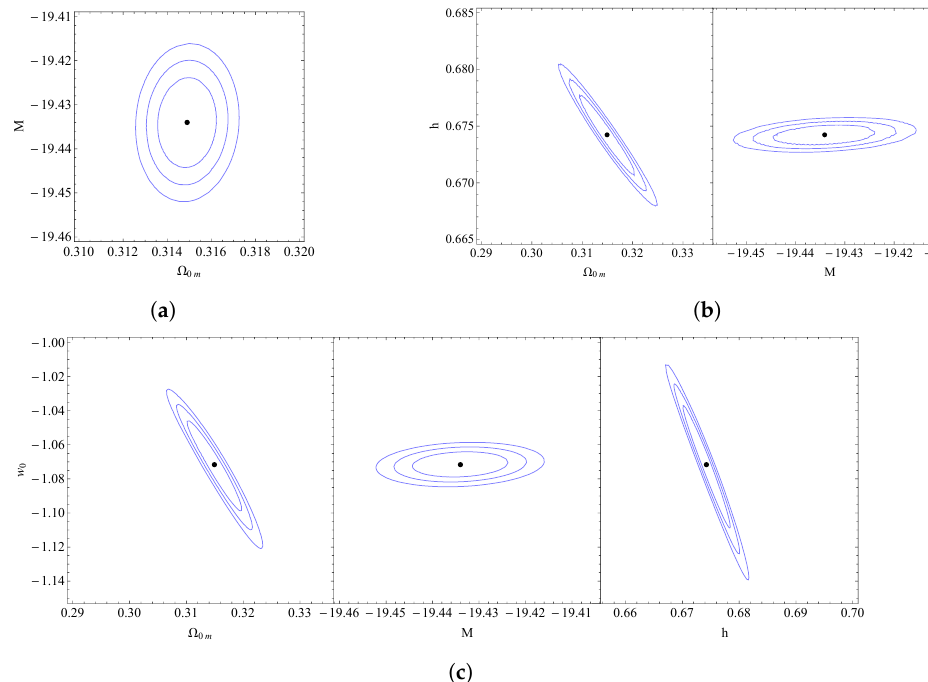
Figure 18. Confidence contours for the CPL model: ( a ) The 1 σ − 3 σ confidence contour in the parametric space ( M − Ω 0 m ) . ( b ) The 1 σ − 3 σ confidence contours in the parametric spaces ( h − Ω 0 m ) and ( h − M ) . ( c ) The 1 σ − 3 σ confidence contours in the parametric spaces ( w 0 − Ω 0 m ) , ( w 0 − M ) and ( w 0 − h ) .